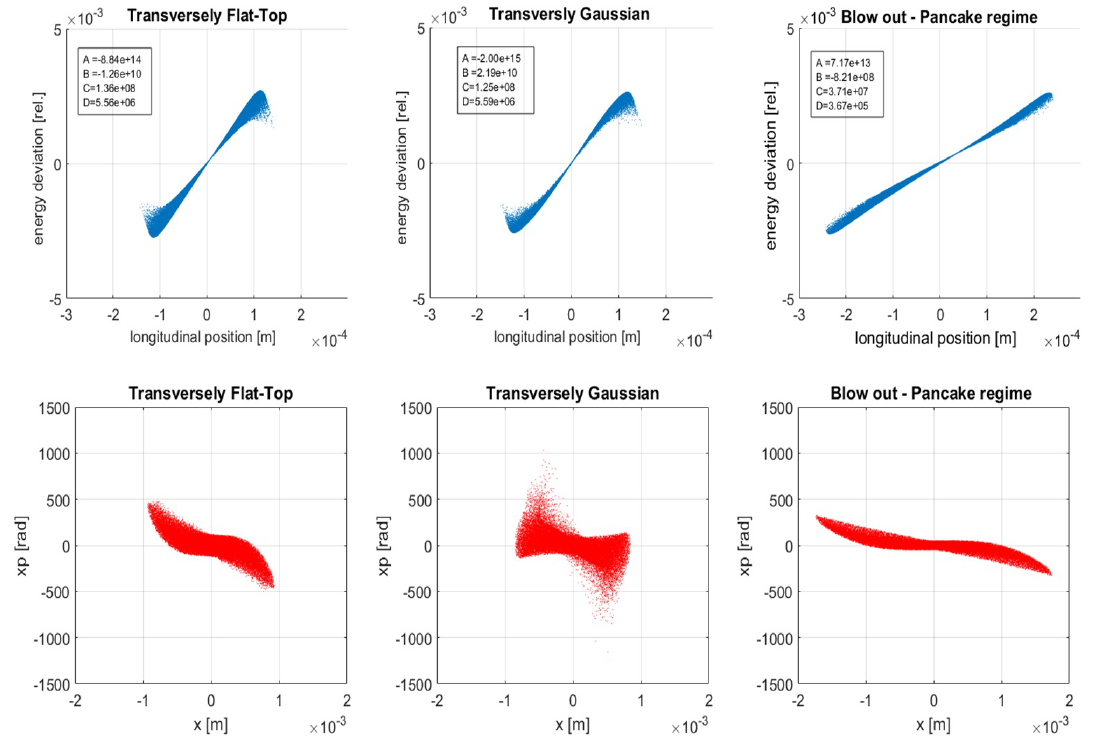
Figure 8. Examples of electron bunches (Q = 0.5 pC) simulated in the ARES RF gun by using different settings of the photo-cathode laser. The plots showing the longitudinal phase space include the values of the coefficients for a fit of the beam distribution: F = A · z 3 longitudinal coordinate related to the beam center of charge position. The flexibility of the laser shaping allows for producing electron bunches with very different shapes of the longitudinal phase space and different non-linear components. The possibility of realizing a transversely flat-top profile allows for improving the non-linearity of the longitudinal phase space and the beam transverse emittance. Working closer to the so-called blow-out regime allows for further reducing the non-linear terms both in the transverse and in the longitudinal phase-space. The simulations have been performed using the code ASTRA [32].